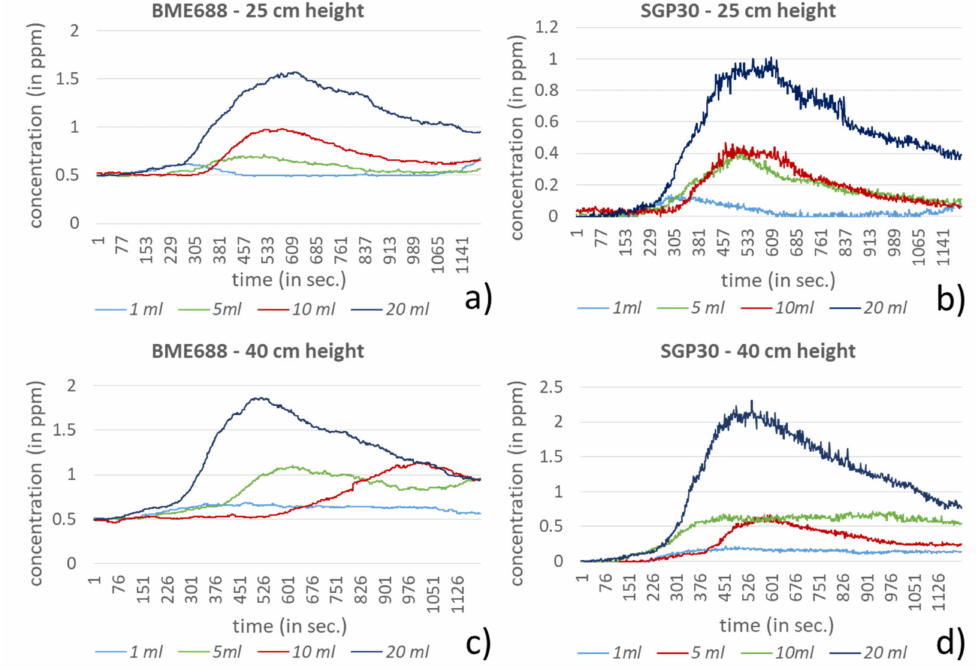
Figure 11. Response of BME688 and SGP30 for different amounts of dichloromethane and for 25 and 40 cm height above the emission source. In ( a ) a measurement height of 25 cm for BME688 and ( b ) for SGP30 is used. In ( c ) the measurement height was changed to 40 cm for BME688 and ( d ) for